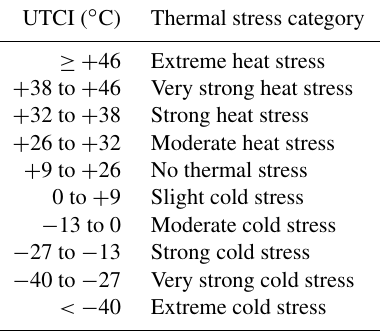
Table 2. Thermal stress classification for UTCI. Modified after Bła˙zejczyk et al. (2013).